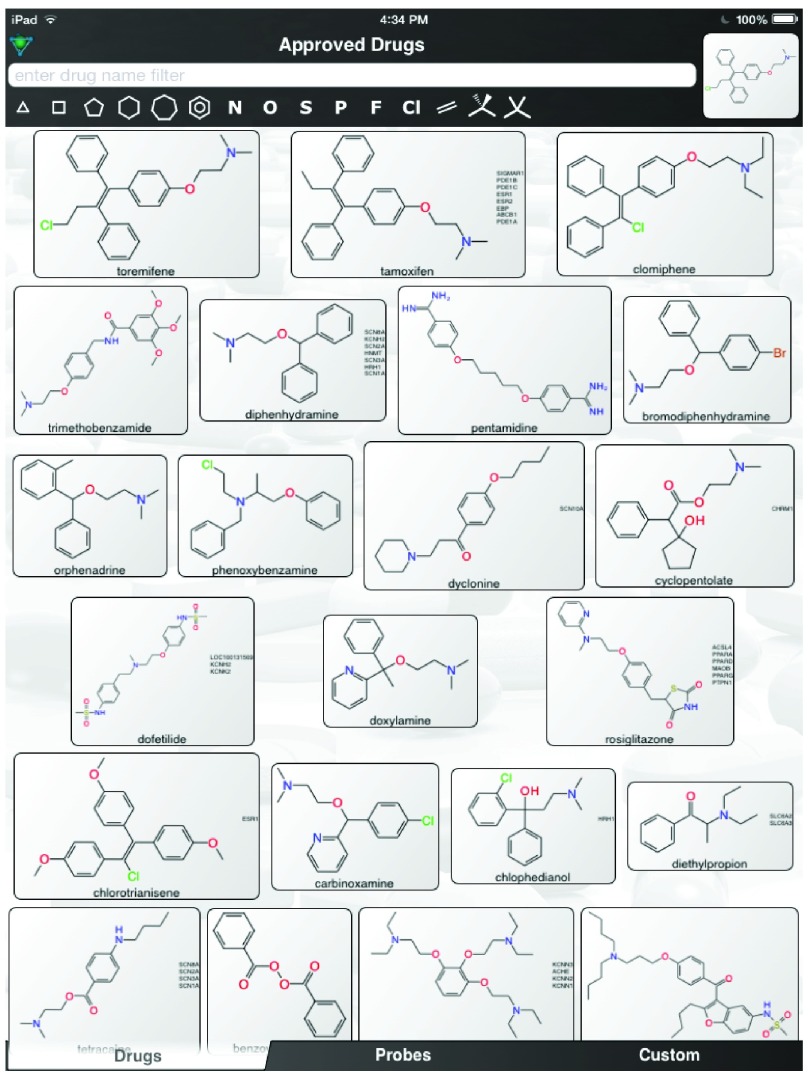
Toremifene similarity in Approved drugs mobile app
http://molmatinf.com/approveddrugs.html.